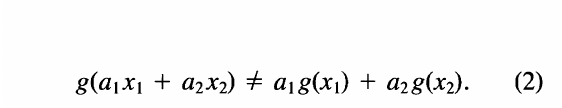
FIGURE 3 Finite-memory nonlinear system.